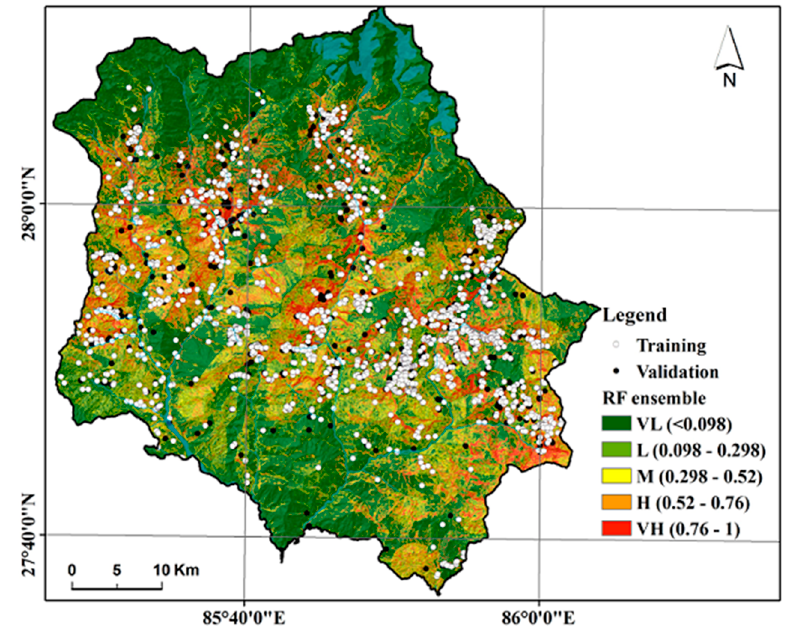
Figure 12. Landslide susceptibility mapping using an ensemble of FR, EBF and WOE using the RF model.